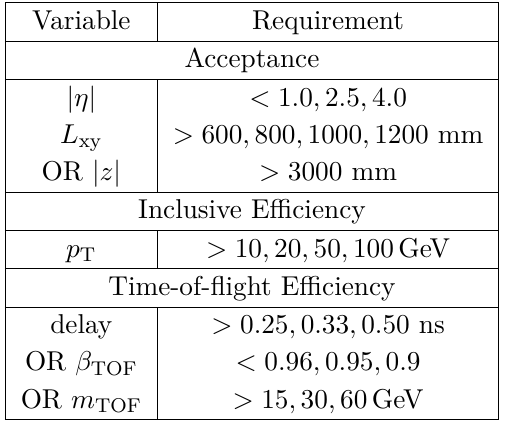
Table 3. Track acceptance and efficiency requirements considered for the inclusive high- p T charged particle selection and for the time-of-flight selection. Events are required to have at least one stau passing these